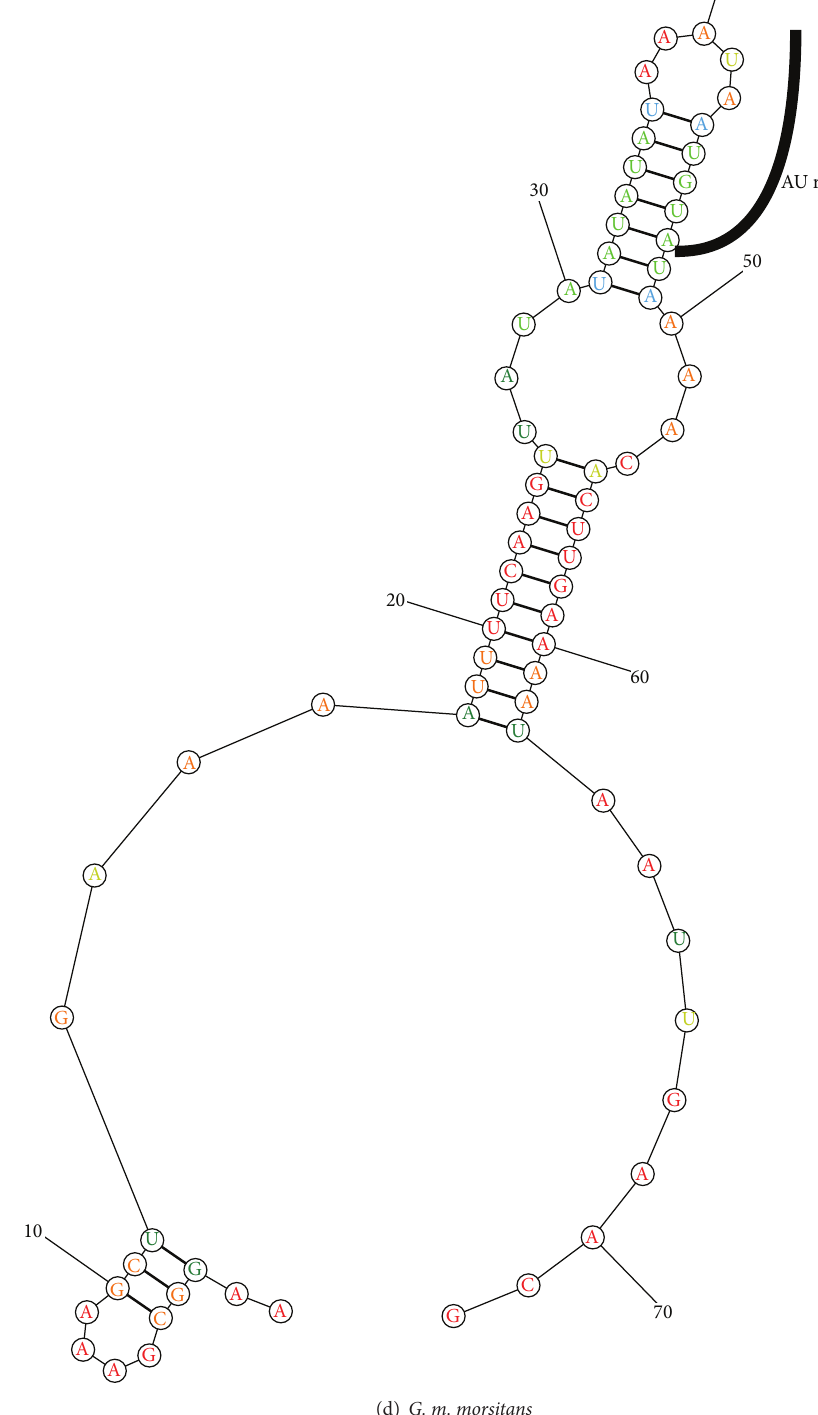
Figure 4: Comparison of proposed secondary structures for four insects’ gap region of 28S rRNA sequences. The AU rich tract that forms the “hidden break” is indicated using an